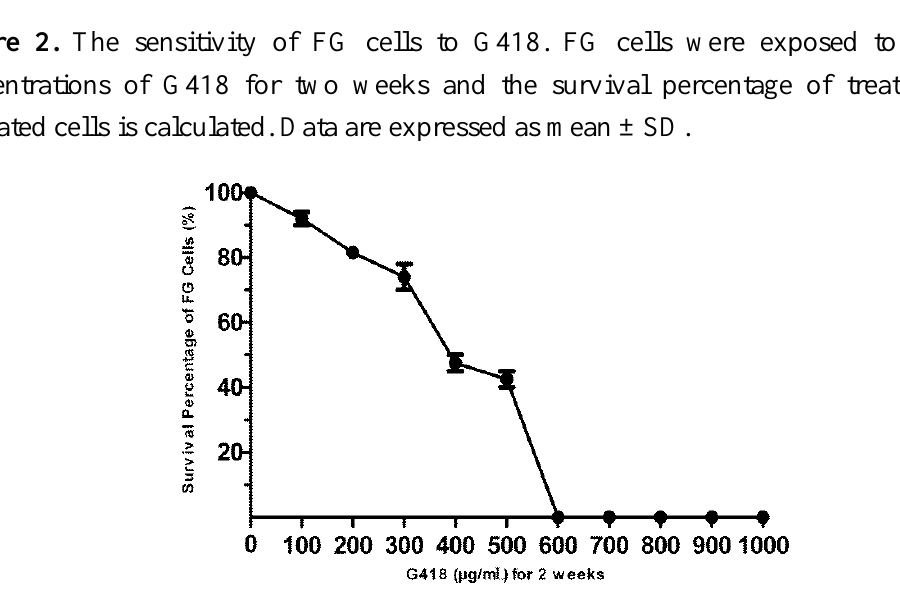
Figure 3. Validation of the endogenous p53 -signaling pathway in FG cells. Examination of the responses of the transiently transformed FG cells to genotoxicant of bleomycin (30 μg/mL for 4 h) using firefly luciferase reporter plasmids of pGL pGL -p53-luc and the Renilla luciferase internal reference plasmid of pRL-CMV. The 3 intact FG cells (not transformed) were used as control. Data are expressed as mean ±